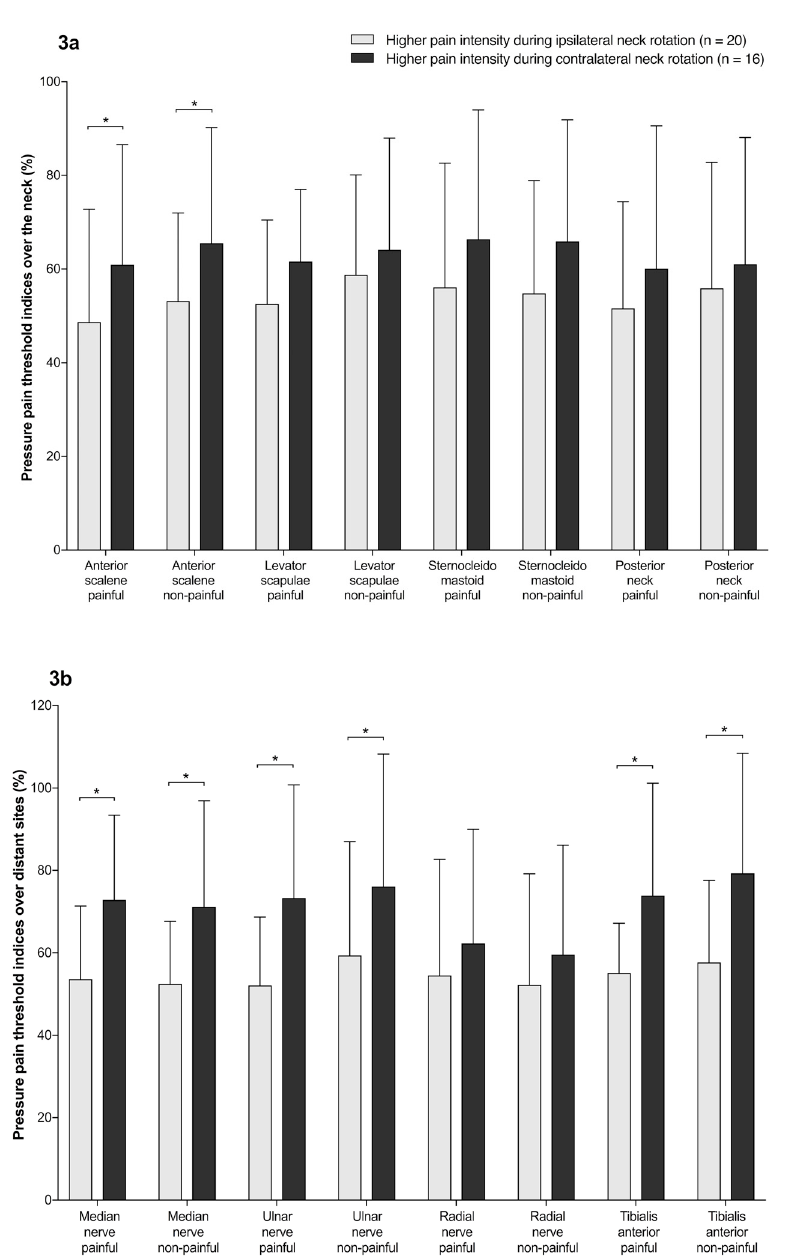
Figure 3. ( a ) Mean ± standard deviation (%) of the pressure pain threshold indices over the neck in females with unilateral non-specific neck pain that can be reproduced during passive neck rotation (*, p < 0.05). ( b ) Mean ± standard deviation (%) of the pressure pain threshold indices over distant sites in females with unilateral non-specific neck pain that can be reproduced during passive neck rotation (*, p < 0.05).